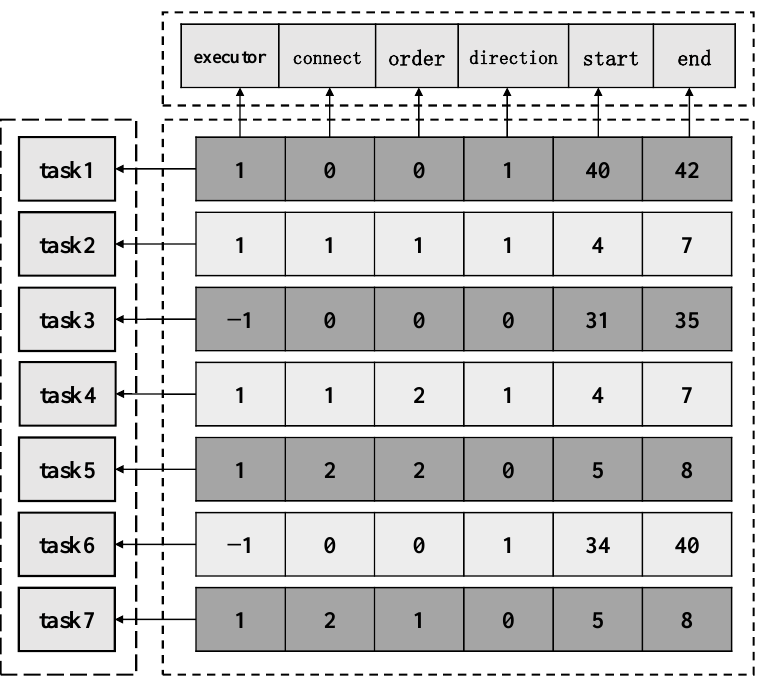
Figure 2. The Encoding of